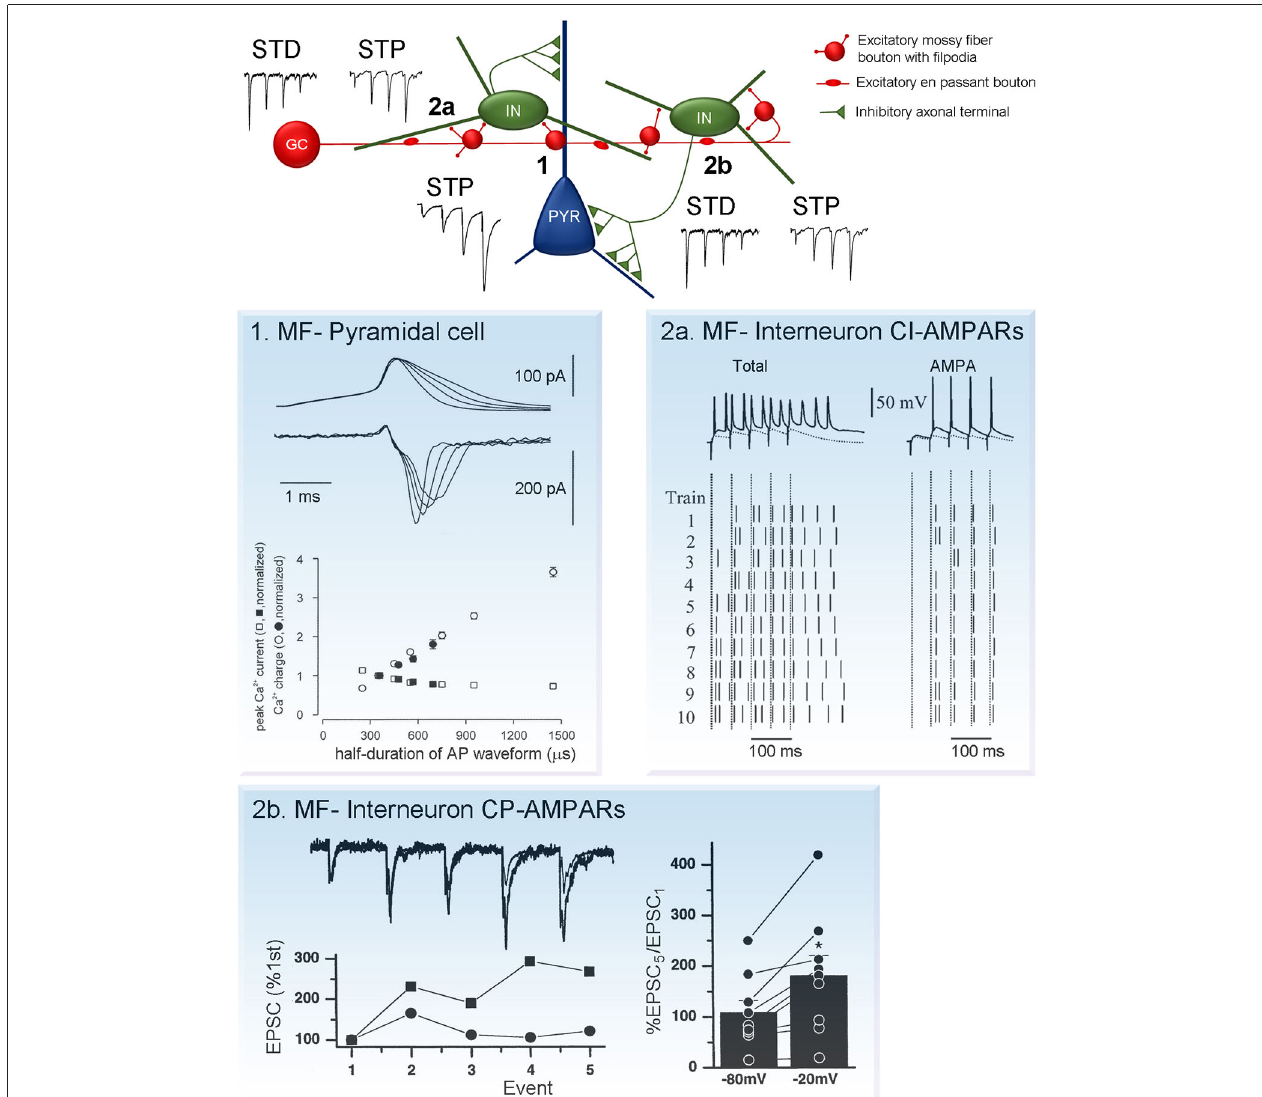
half-duration of the voltage-clamp command. Open symbols indicate values for mock APs, filled symbols represent realistic APs. Adapted from Geiger and Jonas (2000). (2a) MF-interneuron synapses expressing calcium-impermeable AMPARs (CI-AMPARs): contributions of NMDARs and AMPARs to AP transmission. EPSP/AP sequences elicited by trains of stimuli (5 stimuli, 20 Hz) in the absence (left column) or presence (right column) of (2R)-amino-5-phosphonovaleric acid (APV). Upper trace shows a single representative example of response evoked by stimulation. Lower panel shows the raster plot of spikes induced by each of the 5 stimuli in the 10 trials. Each short vertical line represents a single AP, dashed lines represent the timing of the stimulus artifact. Adapted from Lei and Mcbain (2002). (2b) MF-interneuron synapses expressing calcium-permeable AMPARs (CP-AMPARs): voltage-dependent relief from polyamine block enhances facilitation at depolarized potentials. Top, trains of five MF EPSCs evoked by 20 Hz stimulation at two holding potentials ( − 80 and − 20 mV). Bottom, normalizing the first EPSCs in the trains reveals a greater degree of facilitation at − 20 mV. Right, Summary histogram shows that the EPSC 5 /EPSC 1 ratio always larger at − 20 mV, polyamine block is relieved. (Toth and Mcbain,